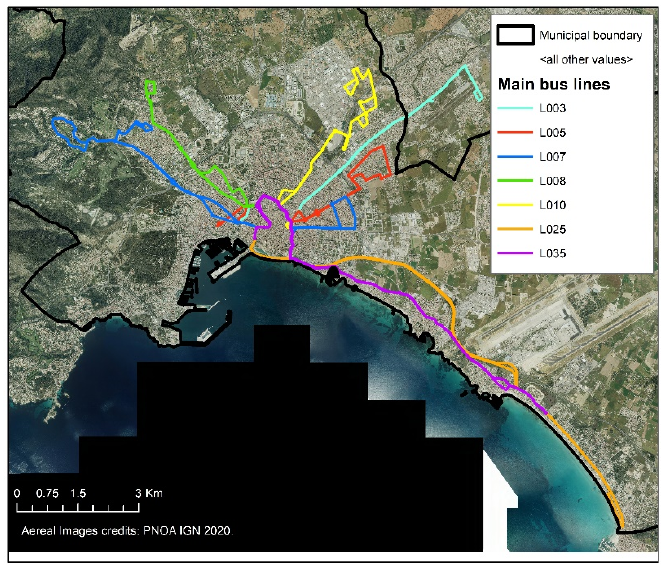
Figure 9. Main bus routes in Palma (Spain).